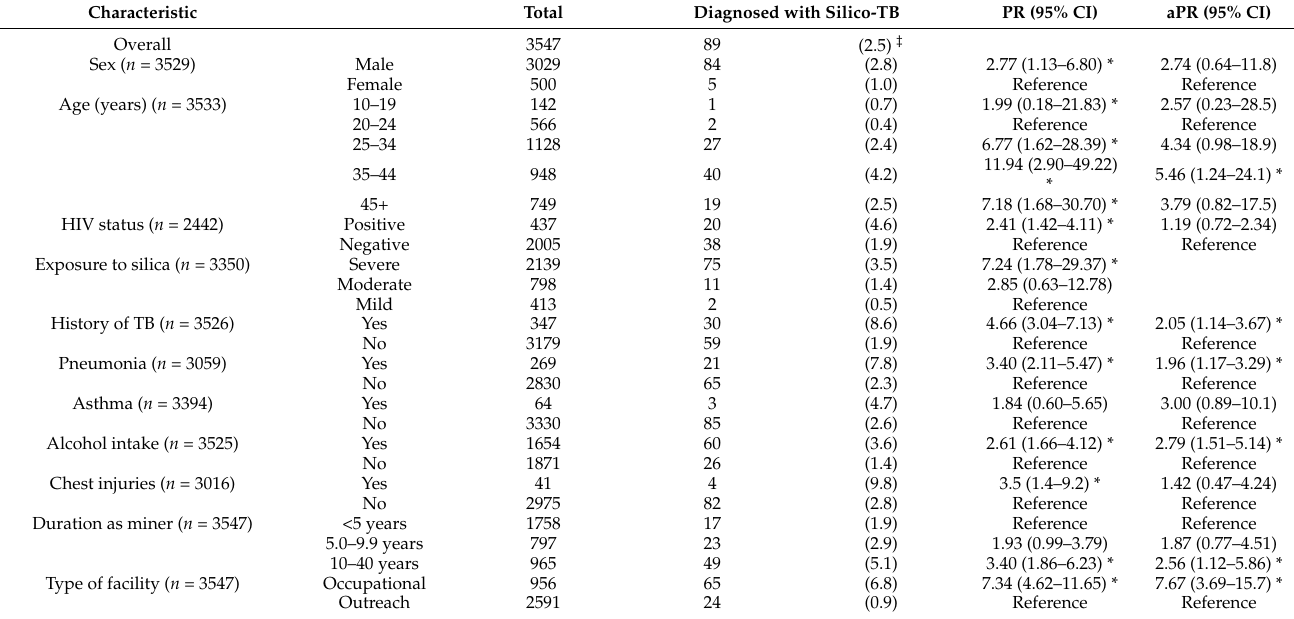
Table 5. Factors associated with silico-TB diagnosis among artisanal and small-scale miners in